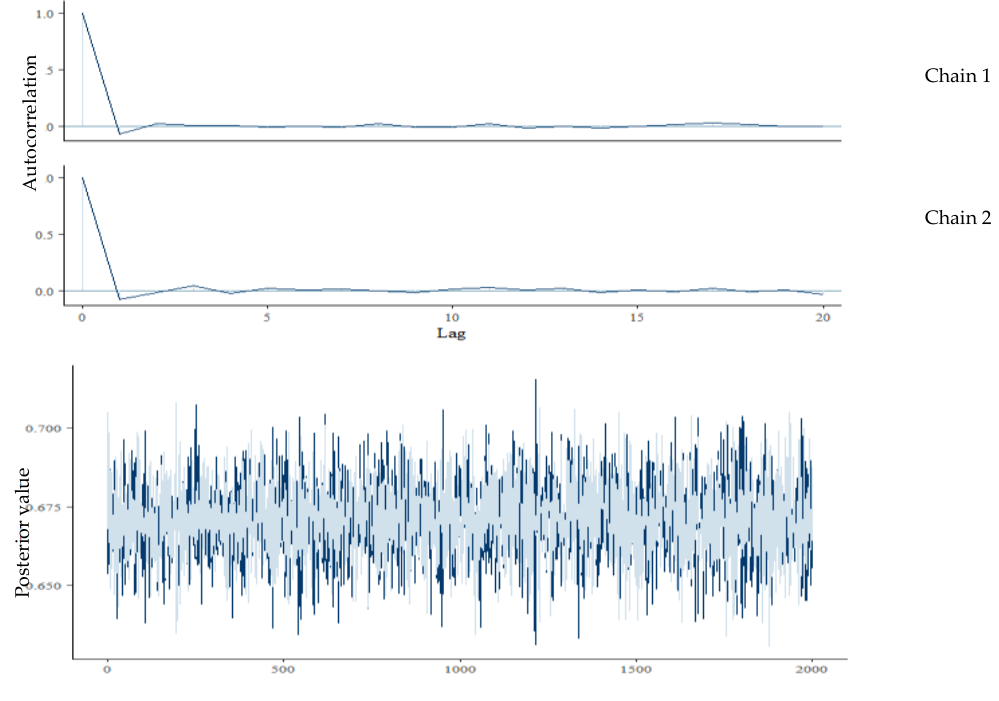
Figure 2. Autocorrelation and trace plots for the coefficient of the variable agroforestry. Chain 1 and chain 2 are the 2 Markov chains used in our MCMC techniques for all estimations.